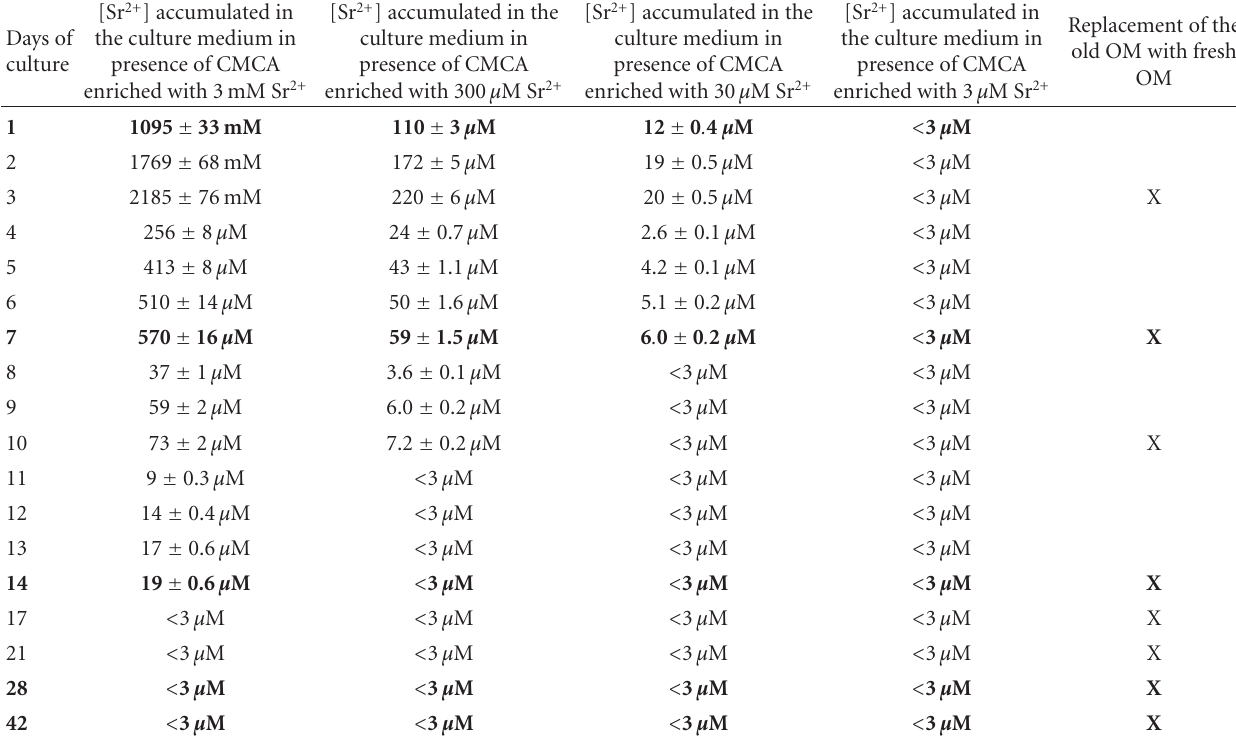
Table 1: Release and accumulation of Sr 2+ in the culture medium from transwells with CMCA enriched with Sr 2+ . Days of culture